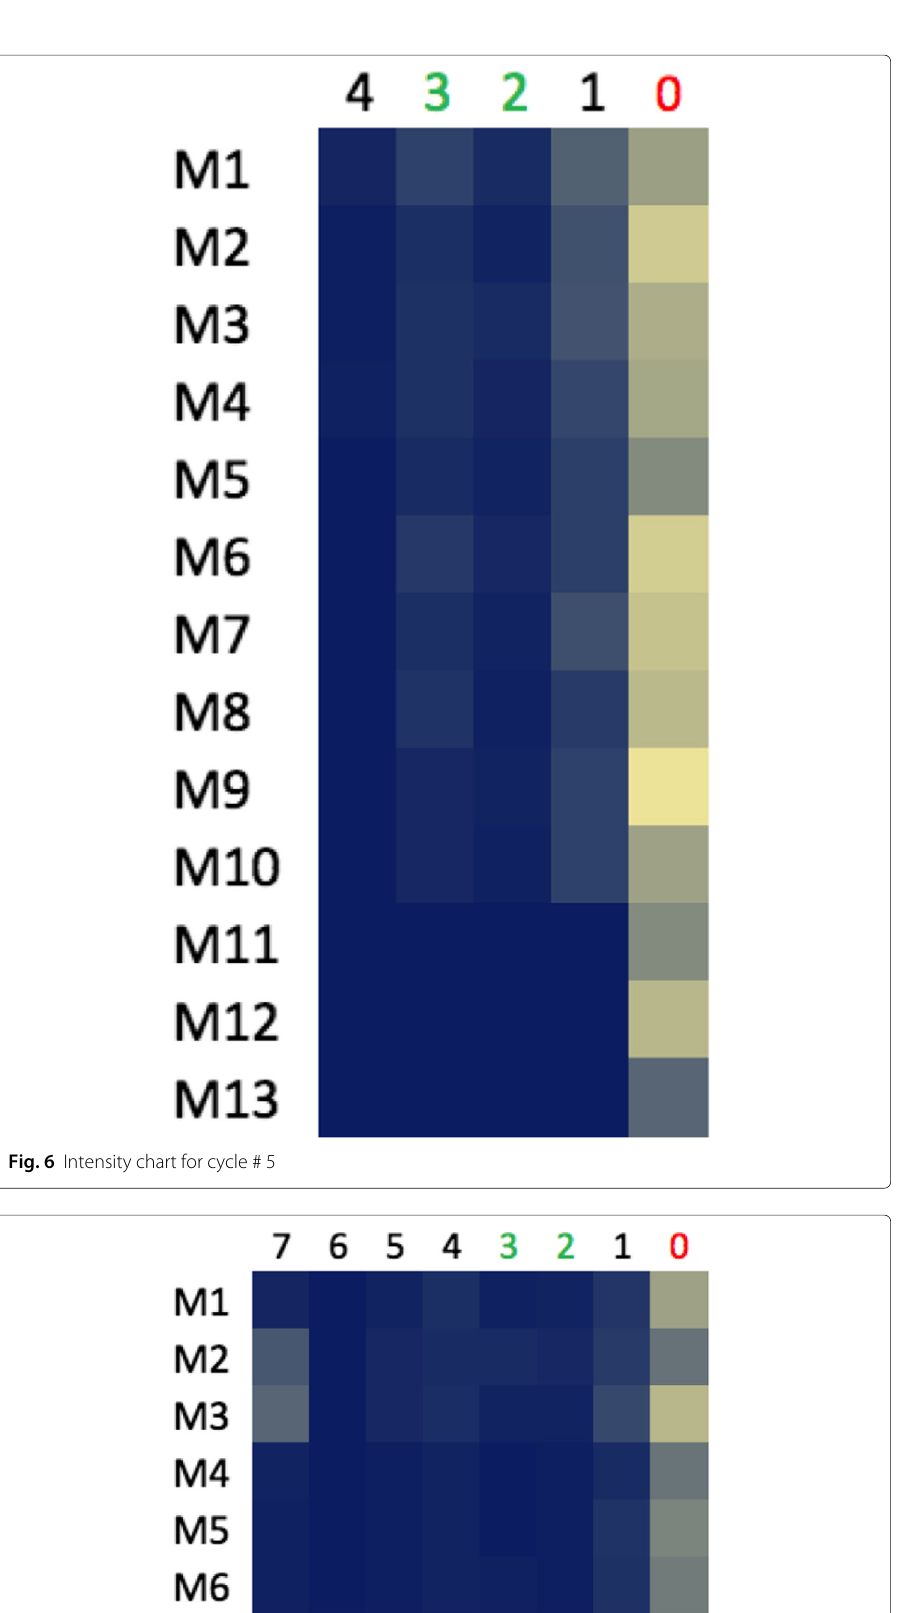
Fig. 7 Intensity chart for cycle #